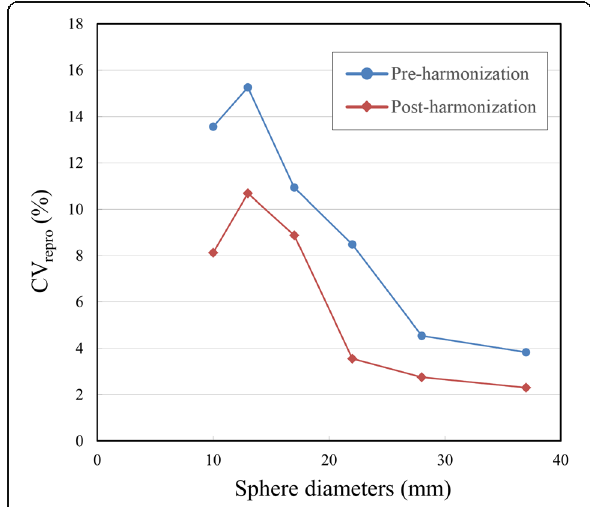
Fig. 4 Effects of harmonization on reproducibility. Pre- and post- harmonization comparisons of coefficients of variation of SUV max for 12 PET scanners (CV repro